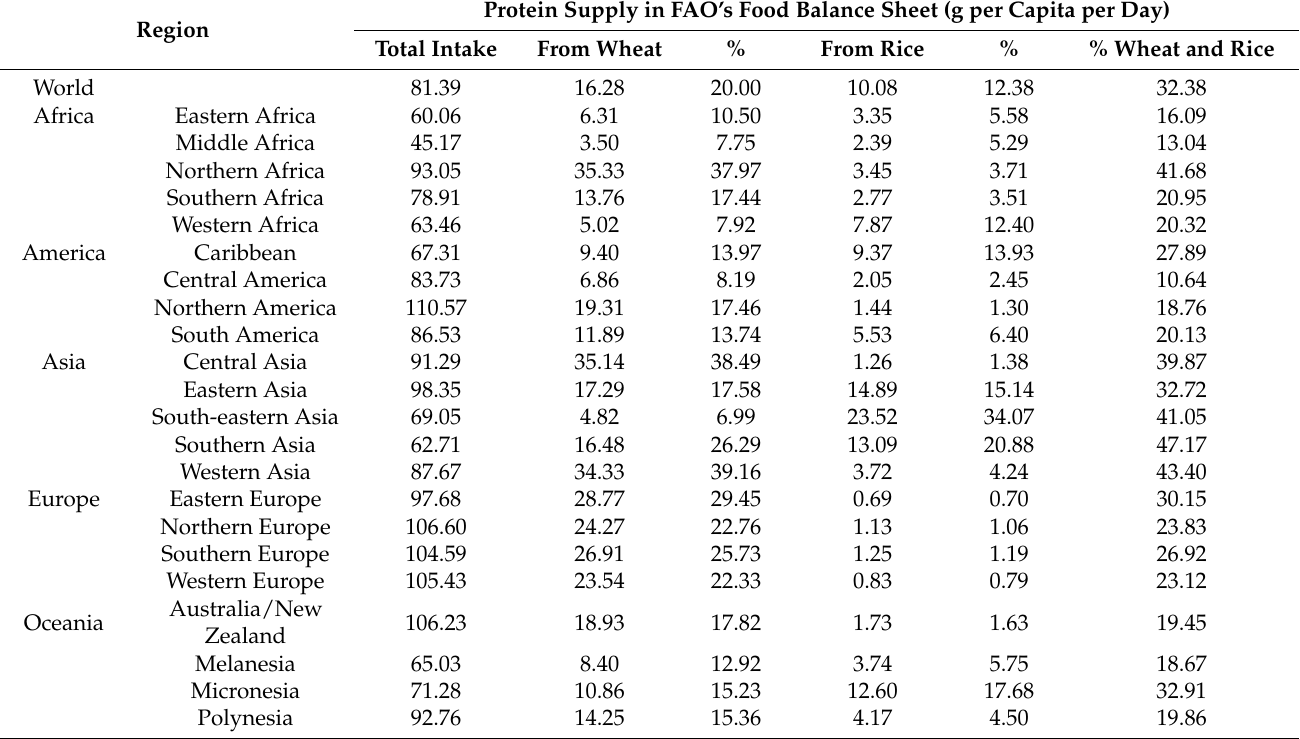
Table 1. Average contribution of wheat and rice to daily protein intake between 2010 and 2019